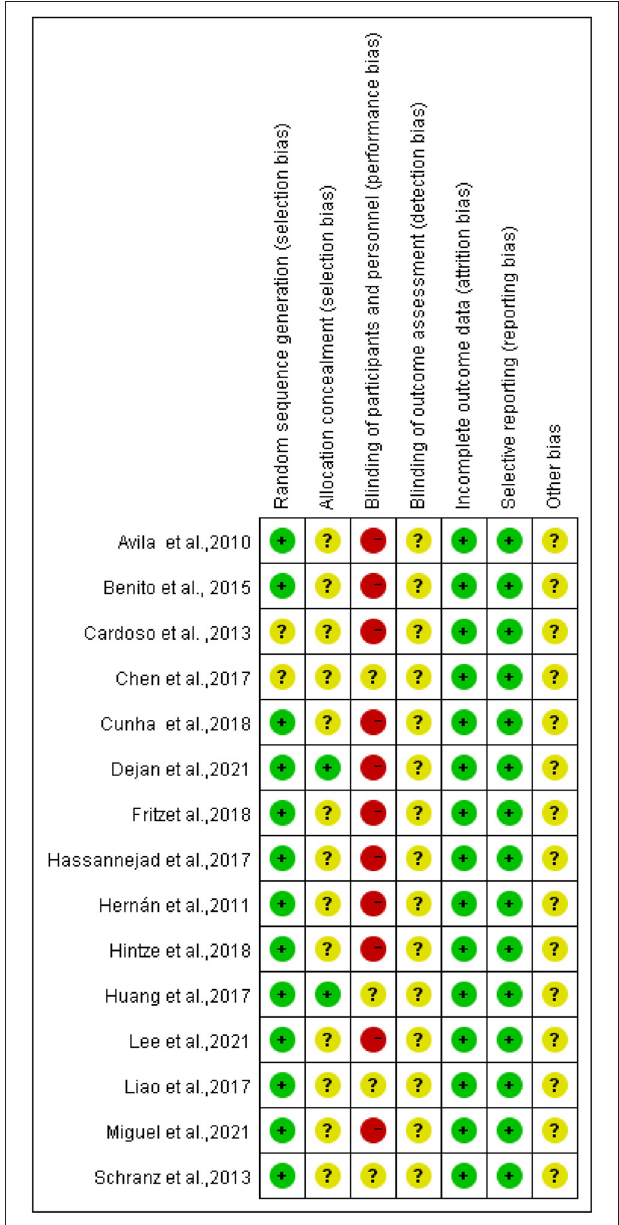
FIGURE 2 | Risk of bias summary of included studies.